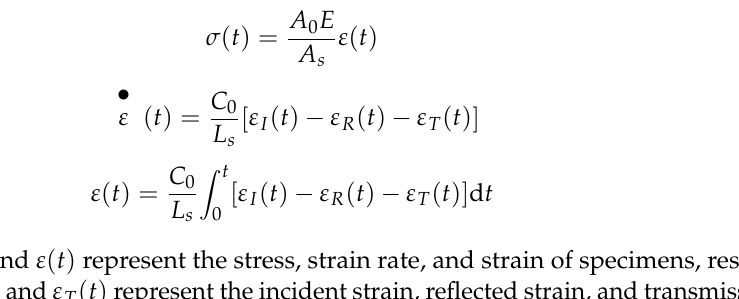
Figure 3. Microscopic test equipment: ( a ) scanning electron microscope and ( b ) X-ray diffraction apparatus.